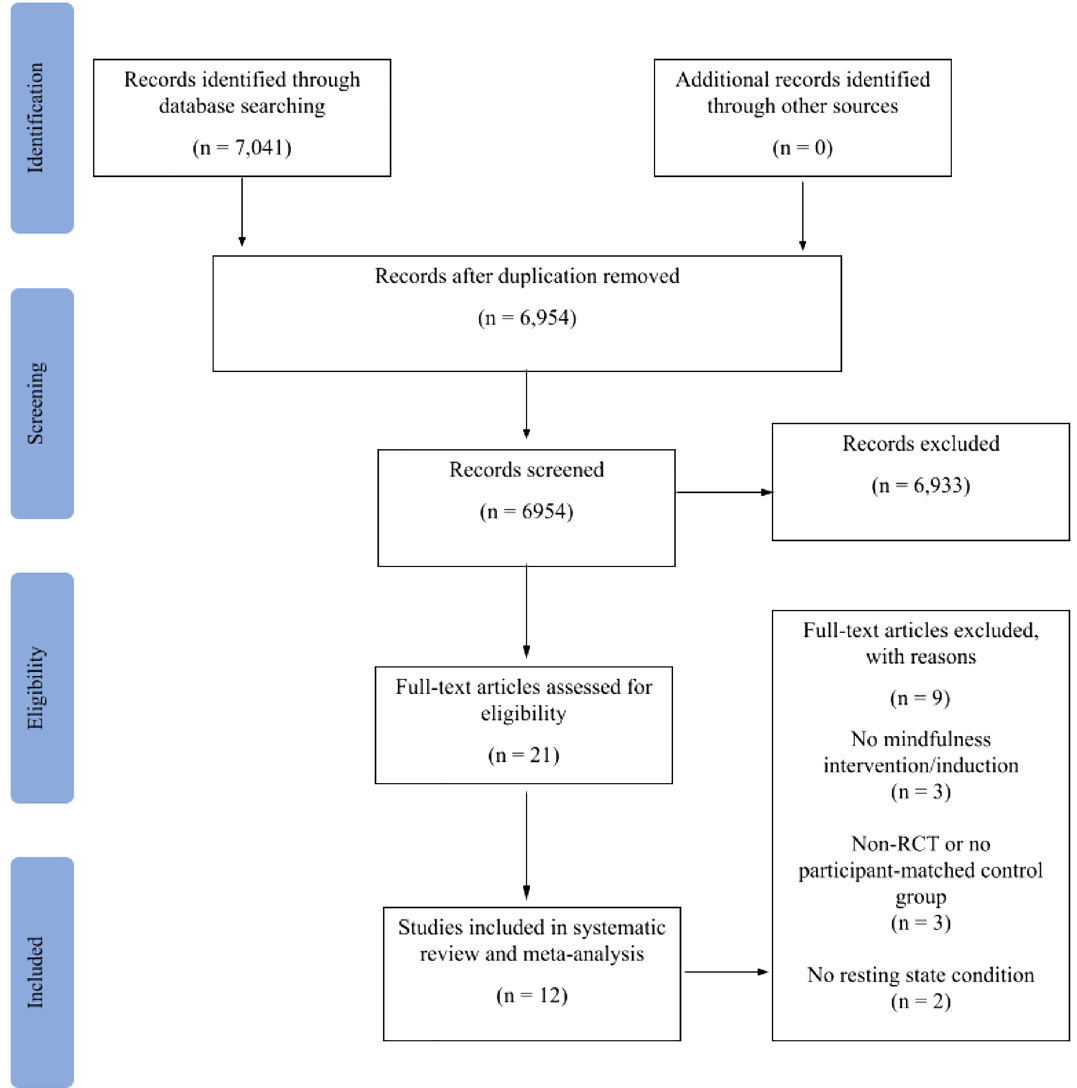
Figure 3. PRISMA flow diagram depicts records identified and screened for eligibility for the